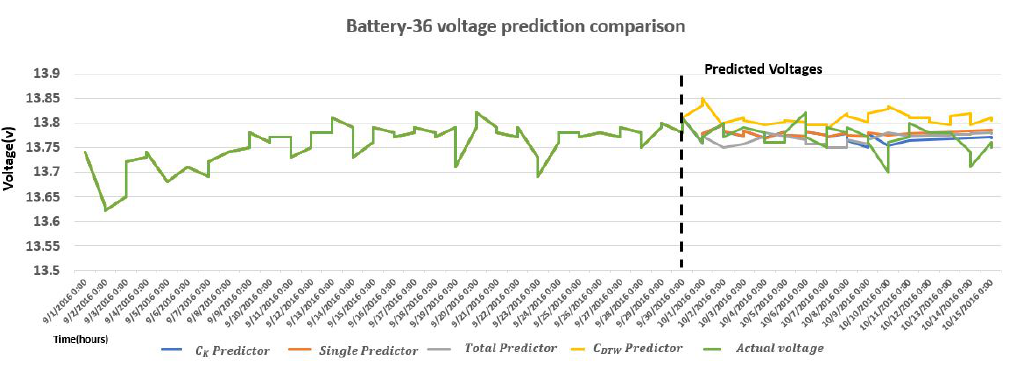
Figure 13. Comparison of measured and ARIMA forecasted voltage with Total predictor of Battery 19.